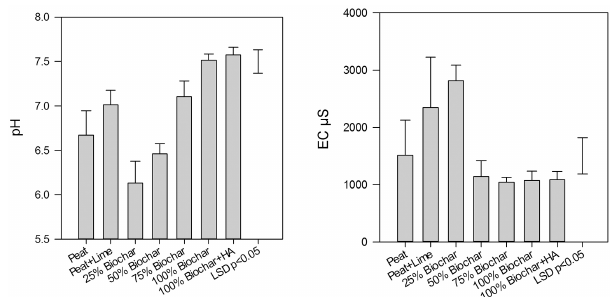
Figure 3. pH (left) and EC (right) of peat, limed peat, biochar and biochar–peat mixtures in leachate 6 weeks after planting ( n = 4, means and standard deviation, HA: humid acid, leonardite, LSD: least significant difference).